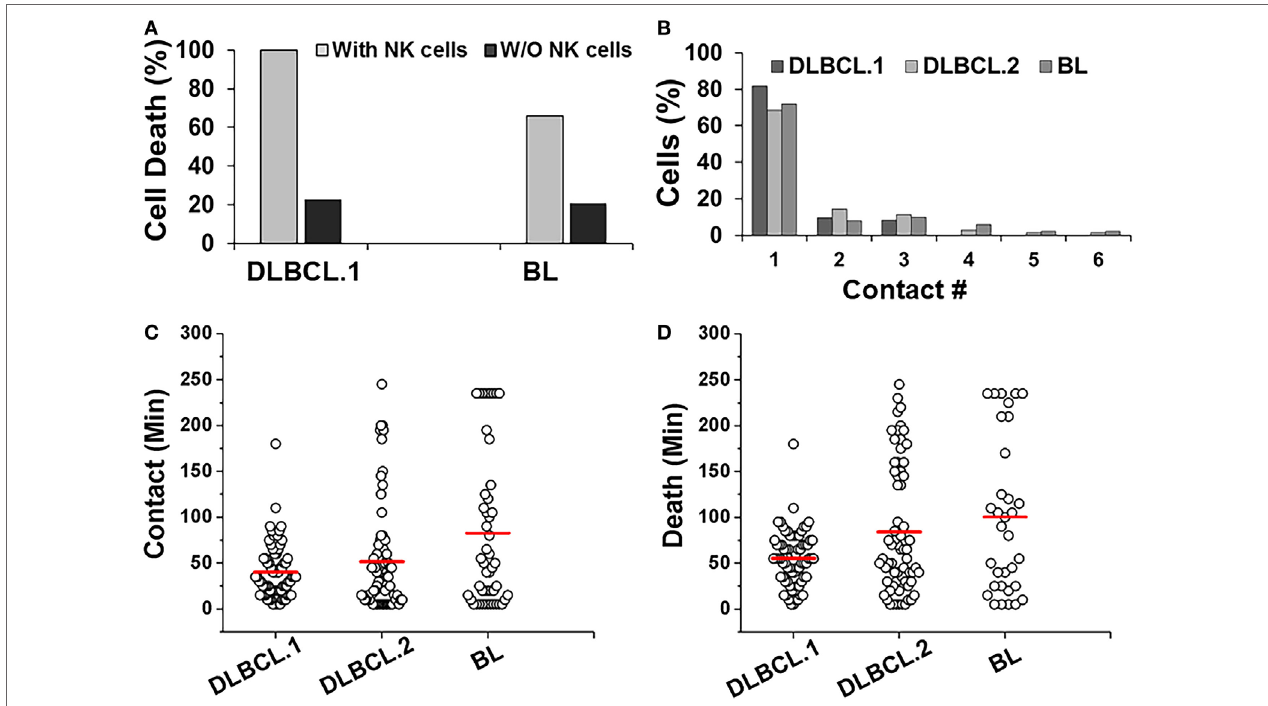
FigUre 6 | Response of patient-derived lymphoma cells in droplets. (a) Death of primary Diffuse Large B cell Lymphoma (DLBCL) and Burkitts Lymphoma (BL) cells in droplets in the presence (with NK cells) or absence (w/o NK cells) of NK cells. DLBCL.1: n = 150; BL: n = 95. (B) Serial contacts made by NK cells with DLBCL.1, DLBCL.2, and BL cells in droplets. (c) Duration of contacts made by DLBCL and BL cells. Mean values are indicated in red. (D) Primary cancer cell death due to contact-dependent mechanisms in droplets. Mean values are indicated in red. Primary cells were obtained from one patient per disease subtype and data reported from one experiment per cell type. (a,B) % values shown for pooled